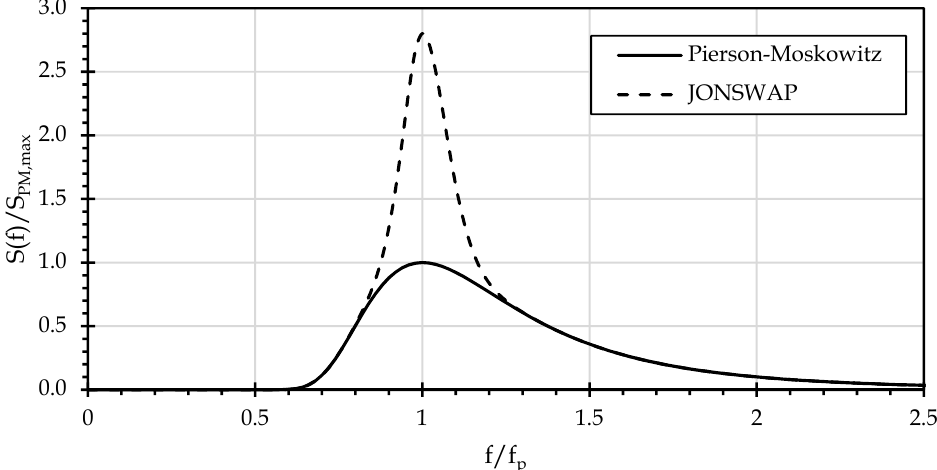
Figure 3. Qualitive comparison of Pierson Moskovitz and JONSWAP spectra.